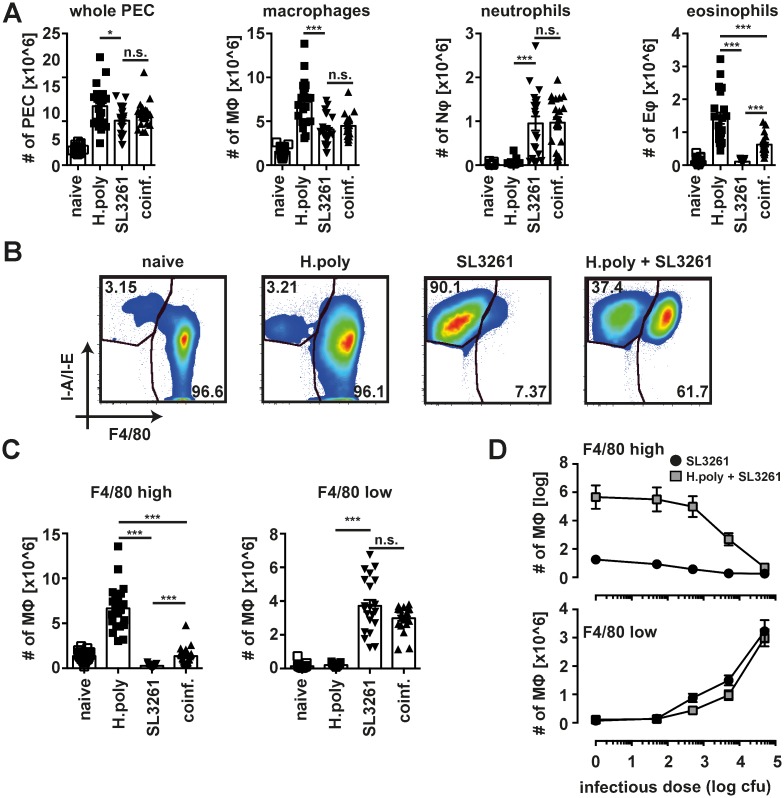
Bacterial co-infection triggers the disappearance reaction in helminth expanded MΦ.(A) Number of total peritoneal exudate cells, MΦ, eosinophils and neutrophils in uninfected (naïve) individually (SL3261 and H.poly) or co-infected mice (B) Representative dot plots depicting MΦ isolated in A. (C) Number of F4/80high and F4/80low MΦ from mice analysed in A. Data pooled from four separate experiments using 5–6 animals per group. Datapoints depict individual animals and bars indicate mean and SEM. (D) Number of peritoneal F4/80high and F4/80low MΦ in single (black circles, SL3261) or co-infected mice (grey squares, H.poly + SL3261) with the indicated doses of SL3261. Animals not receiving bacterial inocula (naïve and single H. polygyrus infection) are included with an arbitrary infection dose of 1 CFU SL3261 to allow depiction on a log scale. Data pooled from two separate experiments with 5 animals per group each. *: p<0.05; **: p<0.01, ***; p<0.001; n.s.: not significant.